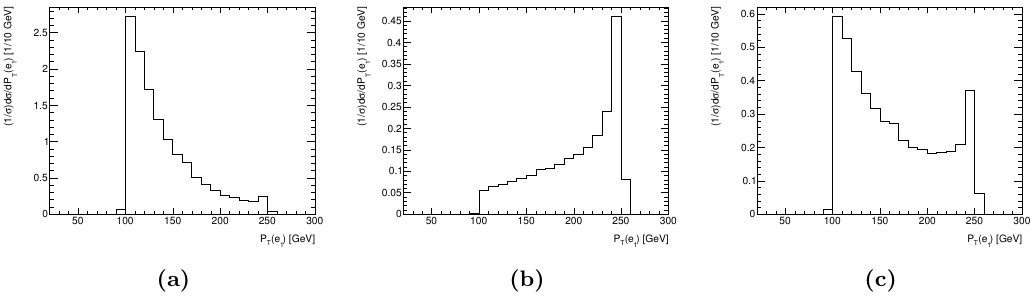
Figure 5. p T distribution of the hardest electron for (a) the SM background, (b) only t -channel Z 0 exchange and (c) total Z 0 and the SM including interference after selecting events by applying the cut p T ( e 1 ) ; p T ( e 2 ) > 100 GeV at the 0.5 TeV ILC for M Z 0 = 1